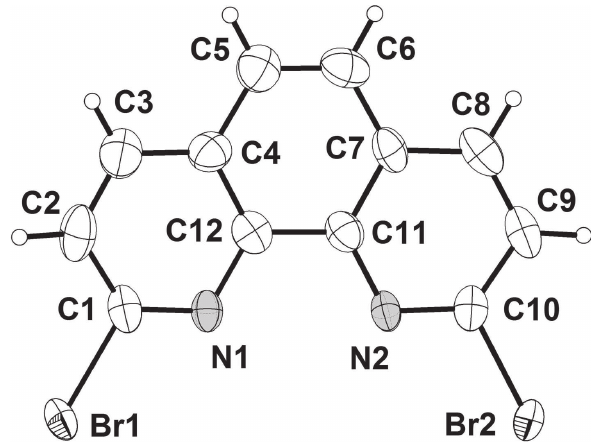
Table 2: Fractional atomic coordinates and isotropic or equivalent isotropic displacement parameters (Å 2